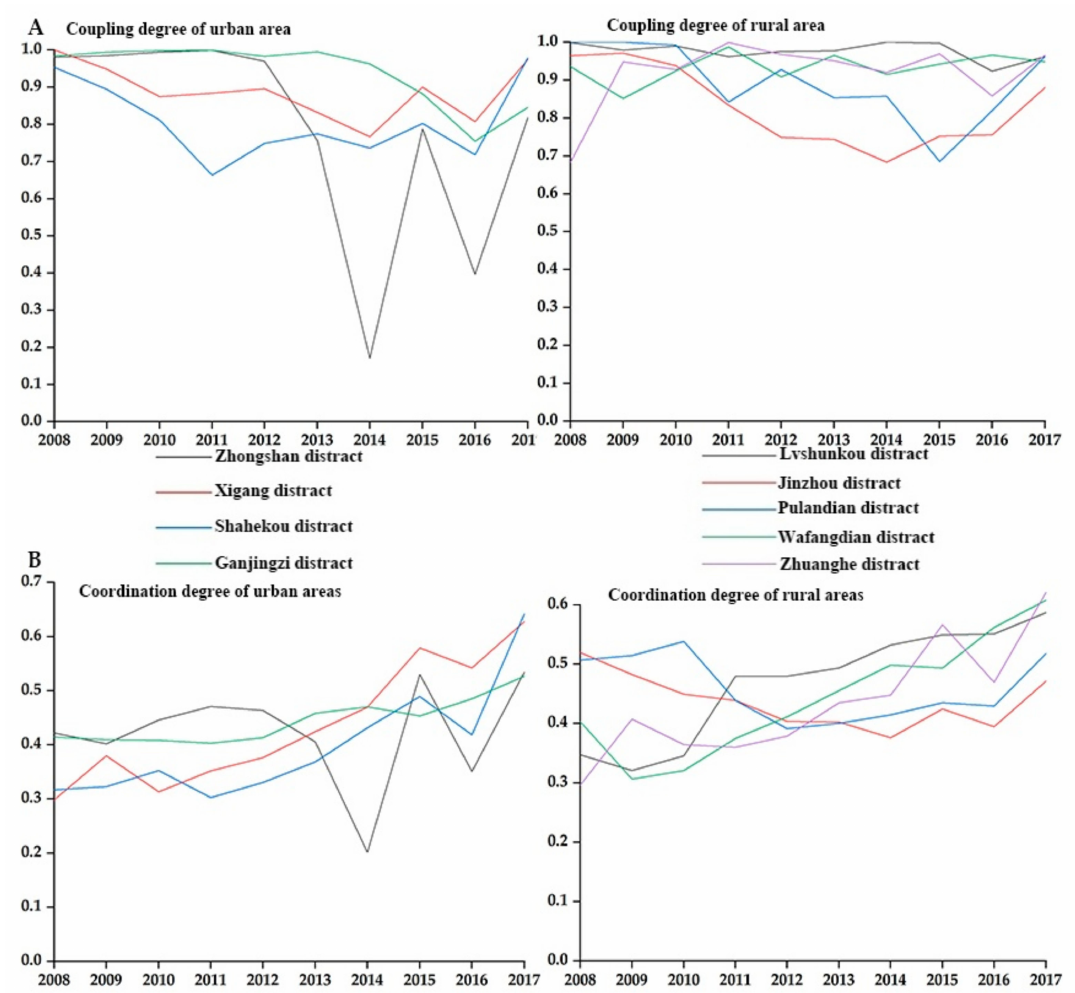
Figure 4. Change in coupling and coordination between urban and rural